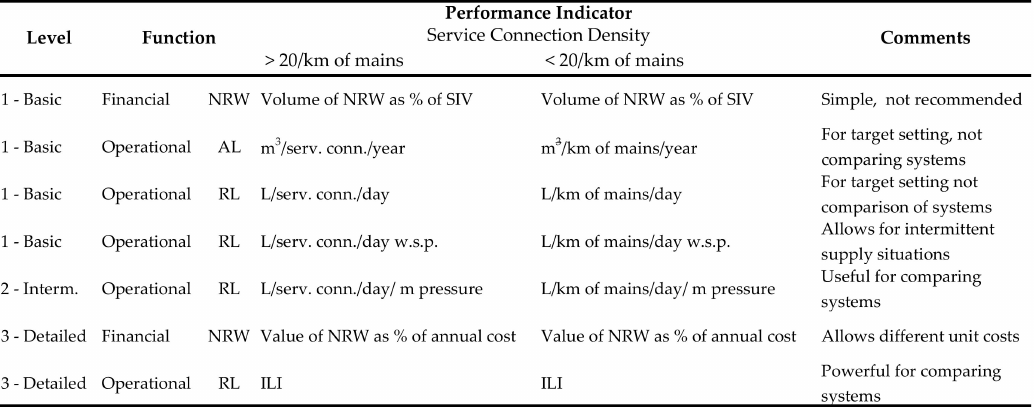
Figure 2. Recommended NRW PIs. (adapted from